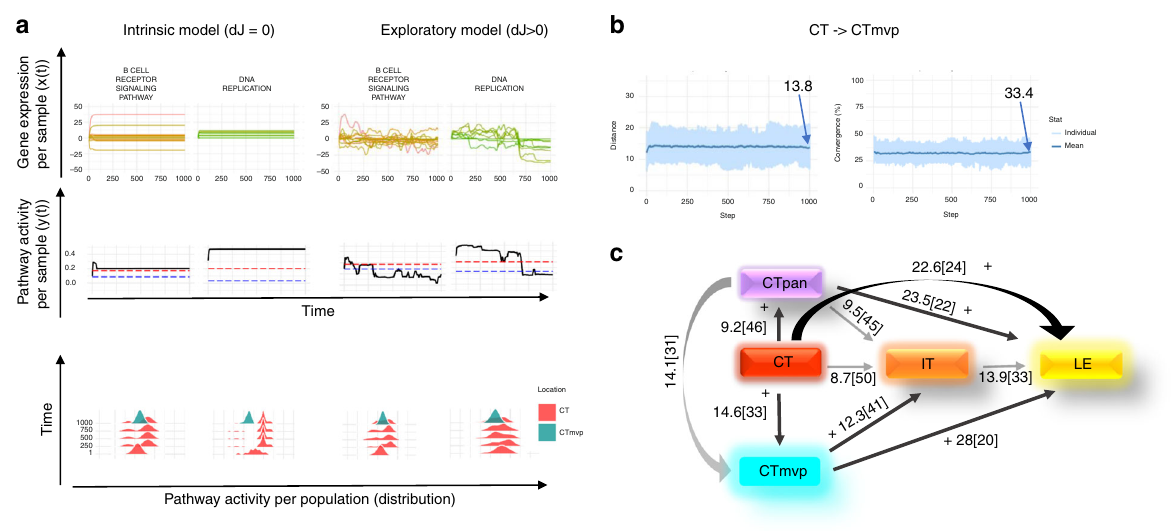
Fig. 3 Cellular response to known and new environmental stimuli. a An example depicting the phenotype transition CT → CTmvp: fi rst, for a given sample changes for two example pathways (DNA replication and B cell receptor signaling pathways) and their corresponding genes were plotted over time. The lower panel show the activity distributions of the two example pathways obtained from the set of samples from each location. Simulation showed that the exploratory behaviors of both pathways differ from the intrinsic behaviors, therefore indicating that new adaptive pathway activities are due to the exploratory ability. b Following the calculations in sub-plot A, global distance per sample, together with the number of converged pathways were calculated over time. Light blue color represents individual samples ’ temporal phenotype distances, and the dark blue line represents the mean value of that global distance. Initial D ( t = 0) was set to 0.1, and the distance ( t = 1000) reached 13.83, while number of converged pathways was reached to 33.4% on that time step. c Simulation results of the updated location-based phenotypes were re-calculated to include exploratory capacity (dJ > 0). Black color with a plus sign denote weights that are different from those of the intrinsic behaviors (dJ = 0) (intrinsic behavior is marked with gray